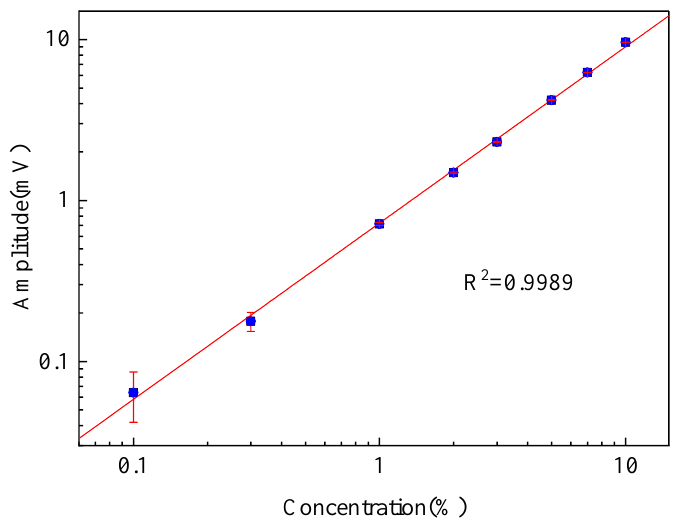
Figure 6. Linearity of QEPAS signal to concentrations of CH 4 . Error bars show the standard deviation from 60 measurements and the magnitudes of the error bars are scaled up by 10 fold.